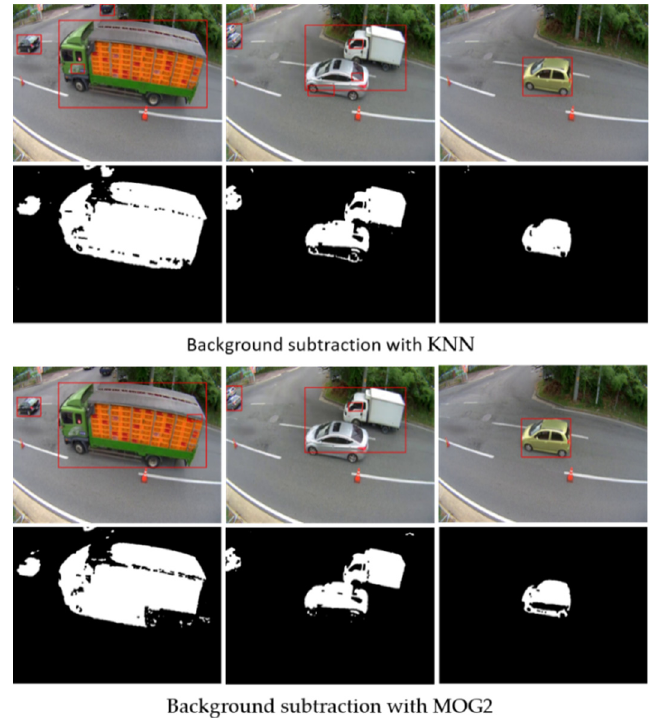
Figure 2. Comparison between two background subtraction methods. KNN: k-nearest neighbor; MOG2: Gaussian mixture-based background/foreground segmentation.